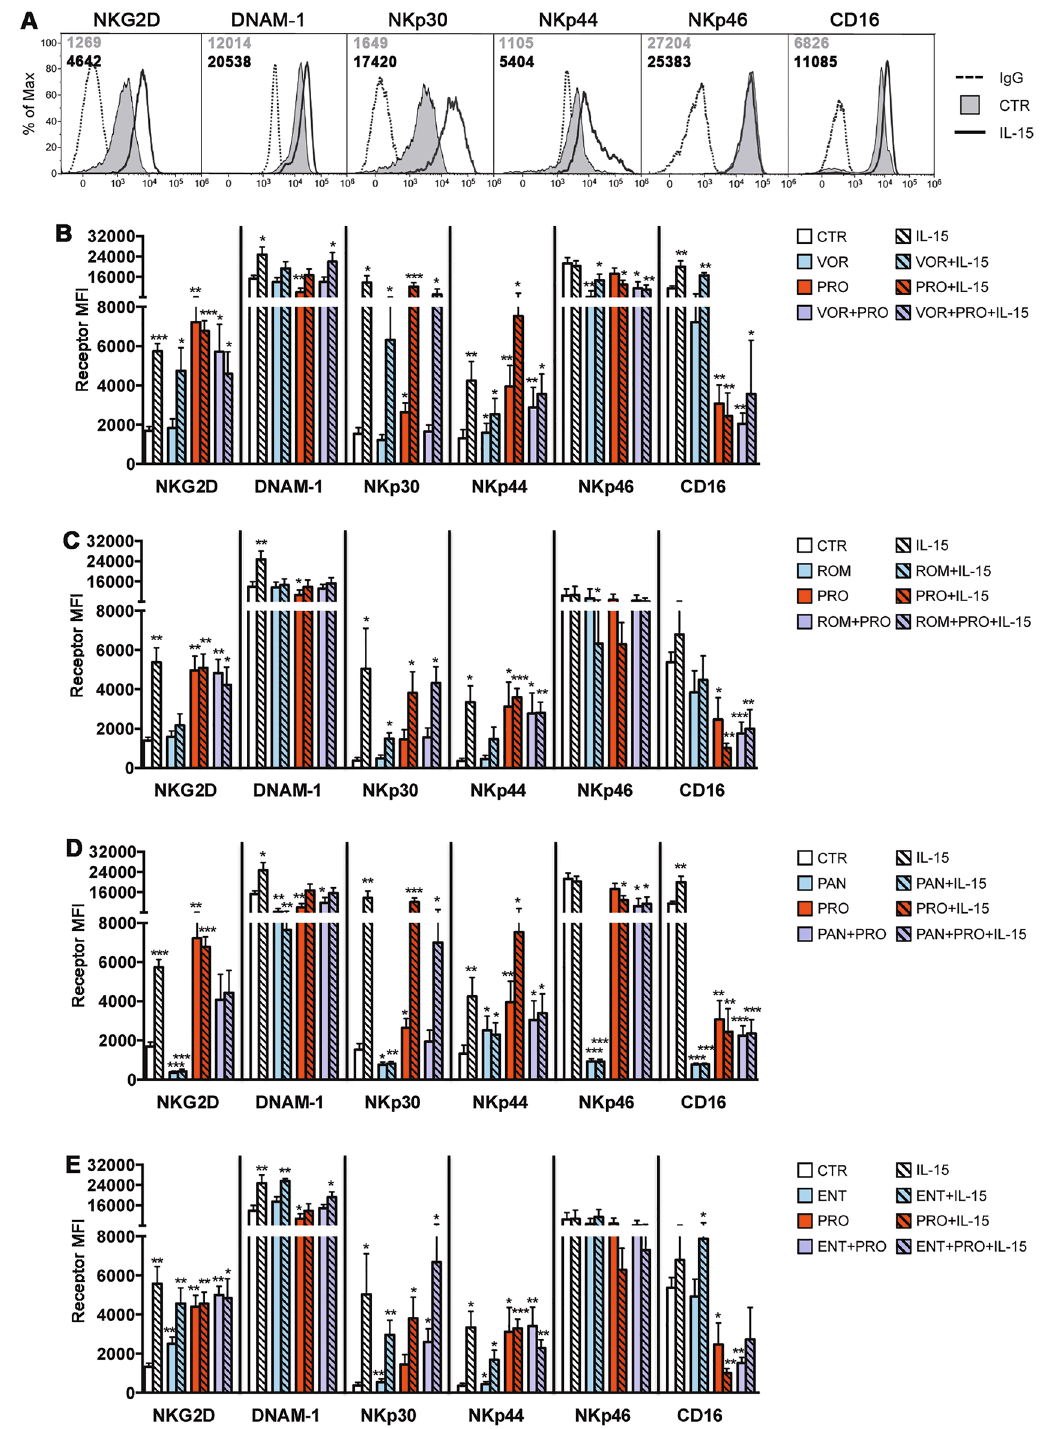
Figure 2. IL-15/LRA combinations variably affect NK-cell phenotype . Purified NK cells were cultivated for 72 h with IL-15/LRA combinations as described in Fig. 1 prior analysis of cell-surface receptors. ( A ) Histograms show representative expression of NKG2D, DNAM-1, NKp30, NKp44, NKp46, and CD16 in NK cells exposed or not to IL-15; mean fluorescence intensity (MFI) values for untreated CTR cells (filled gray) and IL-15-treated cells (solid line) together with control IgG signal (dashed line) are reported. ( B–E ) Each panel represents a set of experiments performed with at least 5 independent donors for a given HDACi used alone or in combination with IL-15 and/or PRO (individual or combined VOR, ROM, PAN, and ENT are depicted in panels ( B ), ( C ), ( D ), and ( E ), respectively). Mean ± SEM MFI is shown. Statistics was performed using paired t -test versus unstimulated control. * p < 0.05; ** p < 0.01; *** p <